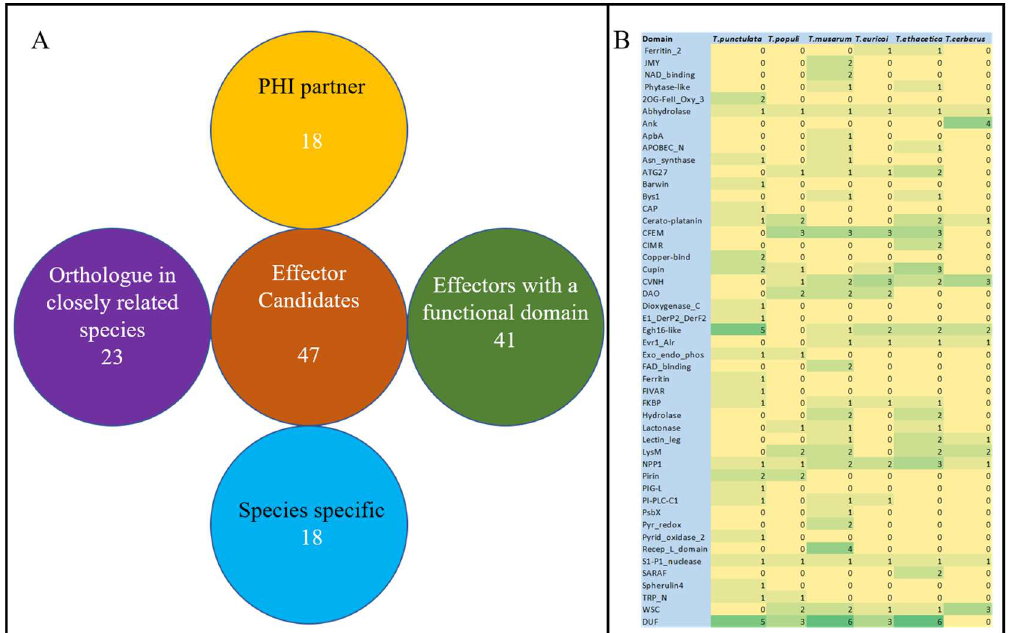
Figure 6. Putative effector proteins in the secretome of Thielaviopsis punctulata . ( A ) Overview: EffectorP identified a total of 47 putative effectors. Among these, functional domains were identified in 41 effectors. 18 putative effectors were identified as having a PHI partner, orthologues for 23 were found in the closely related species, and 18 were identified as species-specific. ( B ) Functional domains in the putative effector proteins of T. punctulata and closely related species. The number of domains of range 0–6 is represented by a golden to green color gradient.